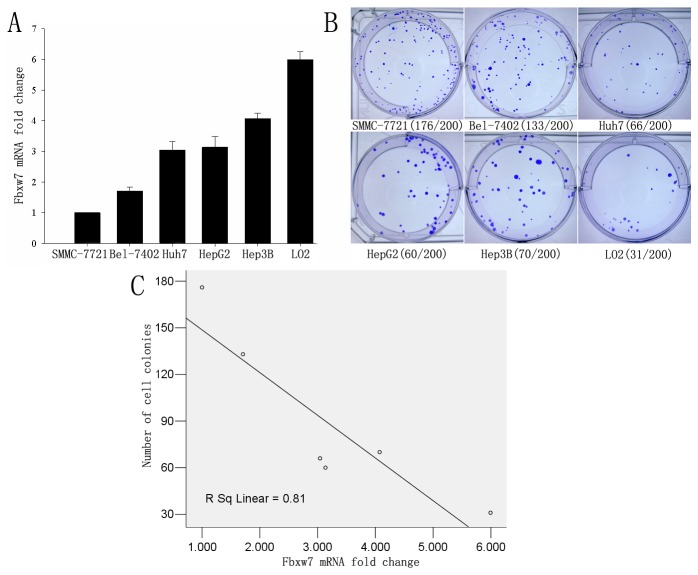
Fbxw7 mRNA expression correlates negatively colony formation ability in HCC cell lines.A) The Fbxw7 mRNA expression level of HCC cell lines (n=3). B) Colony formation assay quantification with HCC cell lines. C) Correlation plot for Fbxw7 mRNA levels and colony number. Values are depicted as mean±standard error.